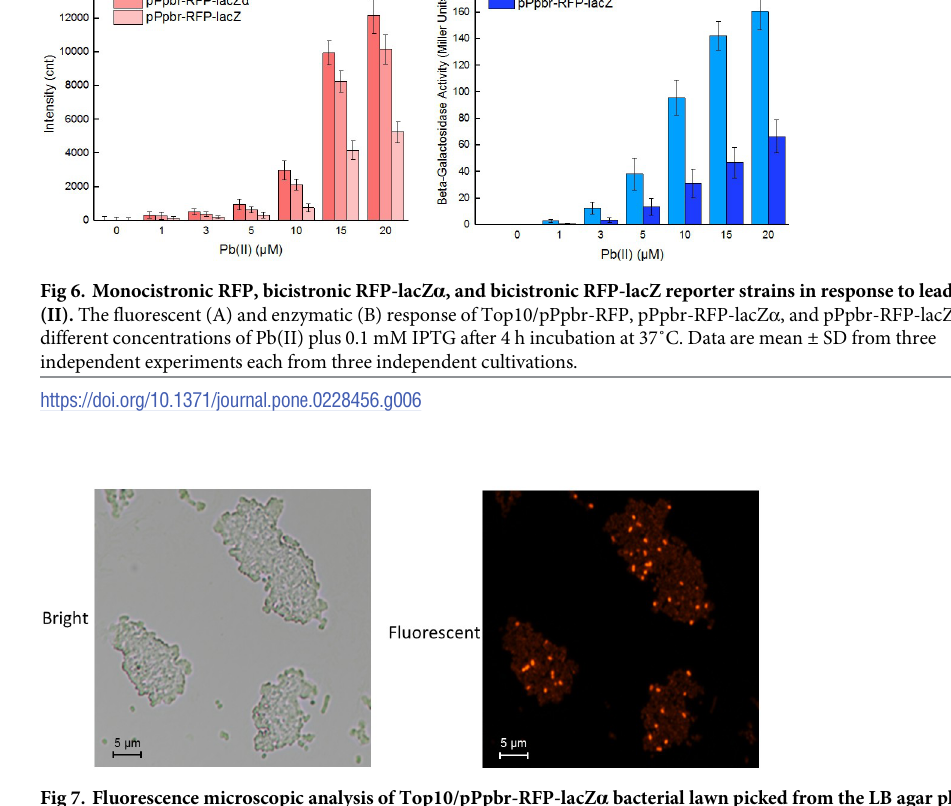
S1 Fig. The cloning/expression region of recombinant plasmids used in this study. DNA sequence and annotation data are all marked. (A) The cloning/expression region of pPlac-